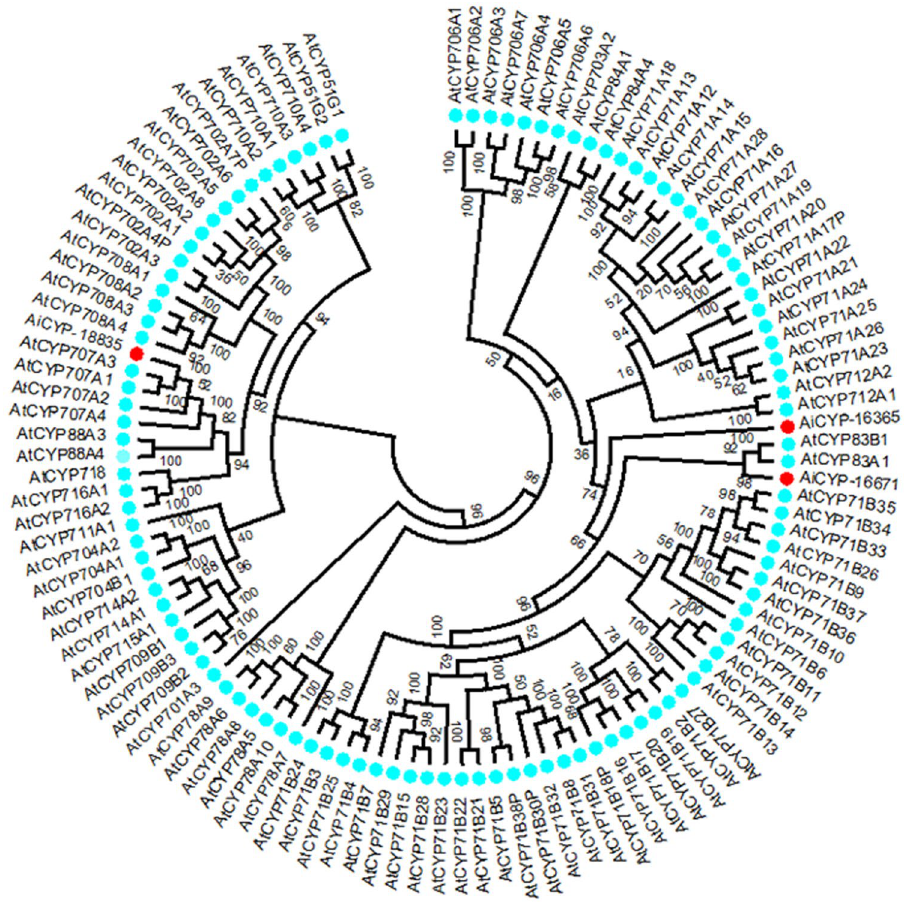
Figure 6. Phylogenetic analysis of genes encoding members of CYP450 family putatively involved in triterpenoid biosynthesis. Phylogenetic tree was constructed for CYP16671, CYP16365 and CYP18835 and members of CYP450 families present in Arabidopsis thaliana by neighbor-joining method using MEGA 5 software. CYP450s of A . indica are indicated by red dots and CYP450s of A . thaliana are indicated by cyan colored